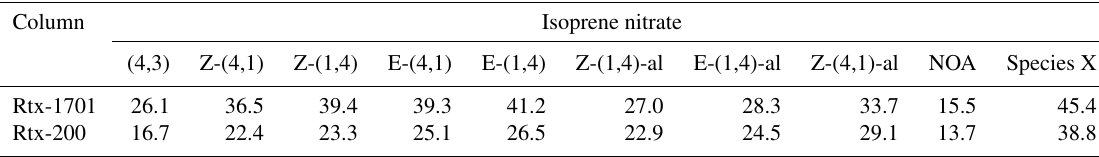
Table 1. Retention times (minutes) for isoprene nitrates on two different stationary phases. Both columns are 30m, 0.32mm ID, 1µm phase thickness. The flow and oven conditions are the same for both columns. A constant flow of He carrier of 4.0mLmin − 1 was used and the oven program was 35 ◦ C (hold 3min), increasing by 15 ◦ Cmin − 1 to 70 ◦ C (hold 1min), + 3 ◦ Cmin − 1 to 110 ◦ C (hold 15min), + 5 ◦ C,´min − 1 to 180 ◦ C (hold